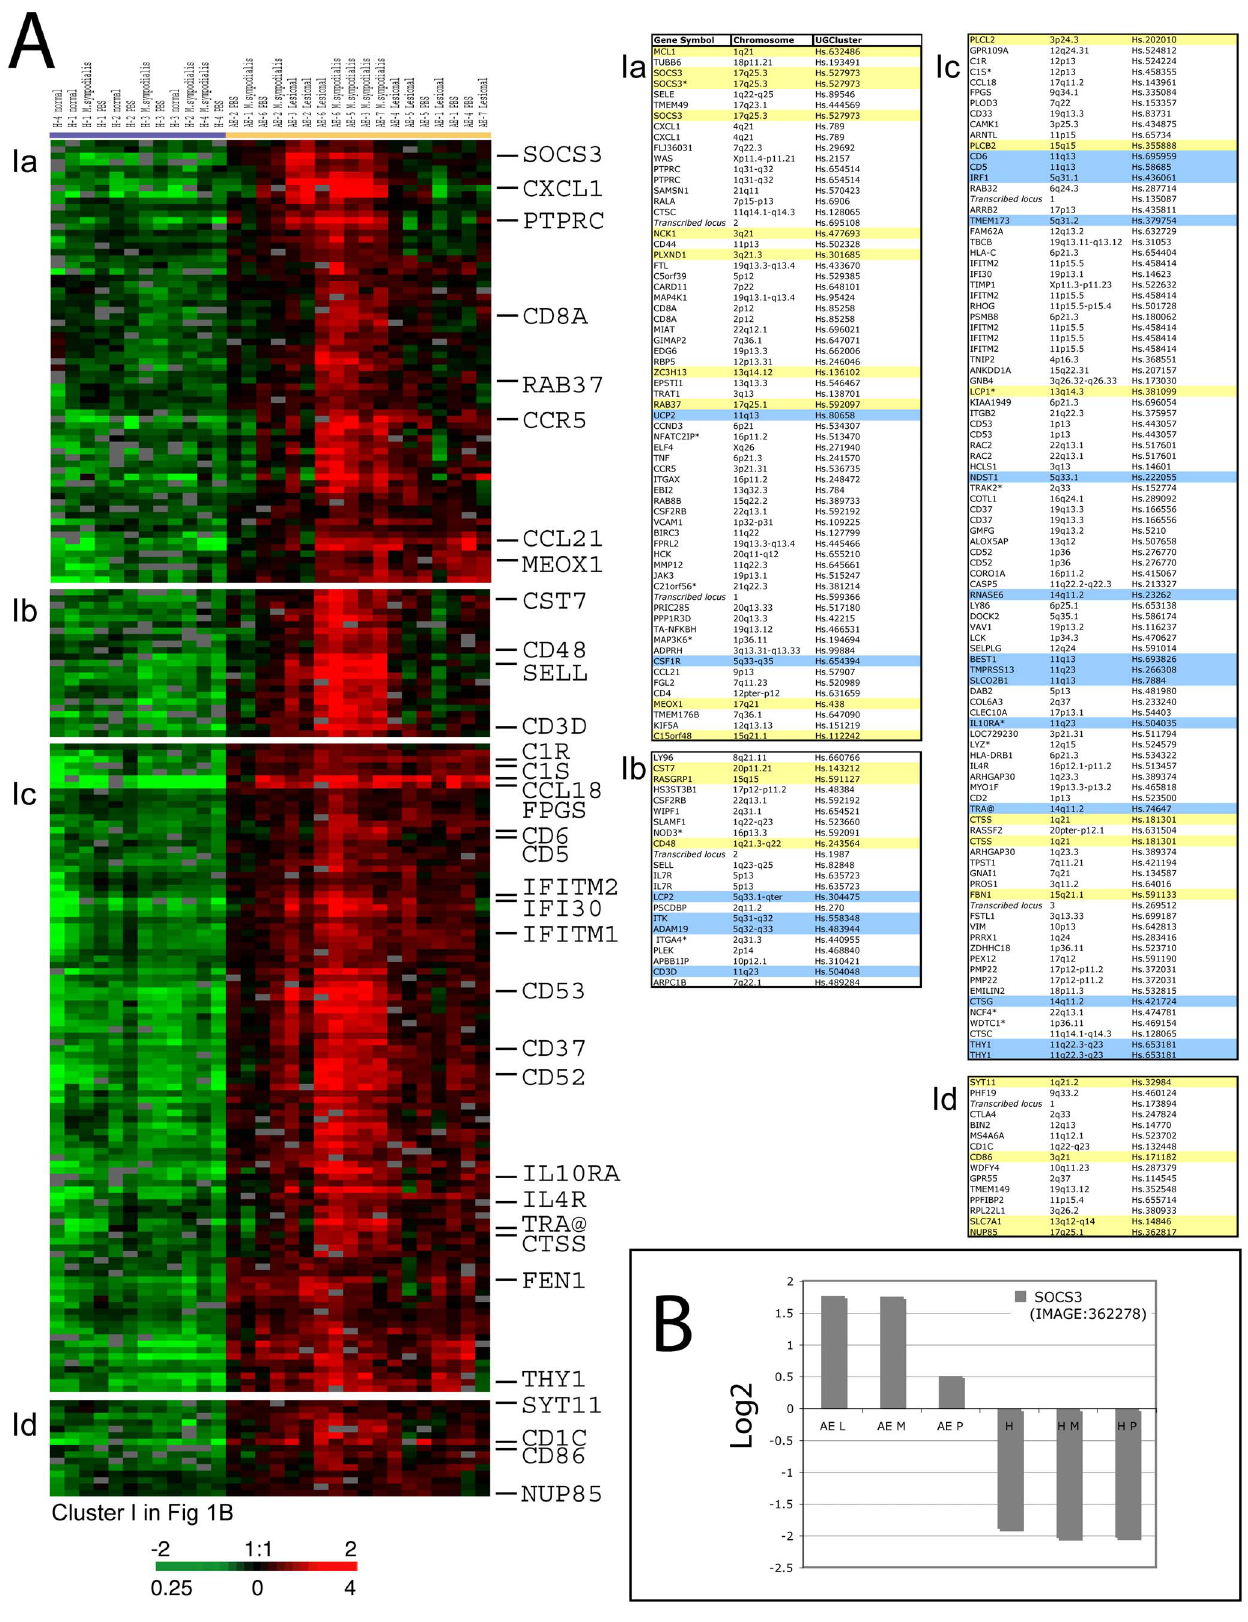
Figure 2. Transcriptional levels of immune and inflammatory genes in AE skin measured using DNA microarrays. (A) A zoomed in picture of the hierarchical cluster analysis showing examples of immune and inflammatory genes that was found to be coordinately over-expressed in AE skin as compared to healthy skin. A detailed list of the genes represented in this cluster is shown in the table (right). Genes localized in genome-